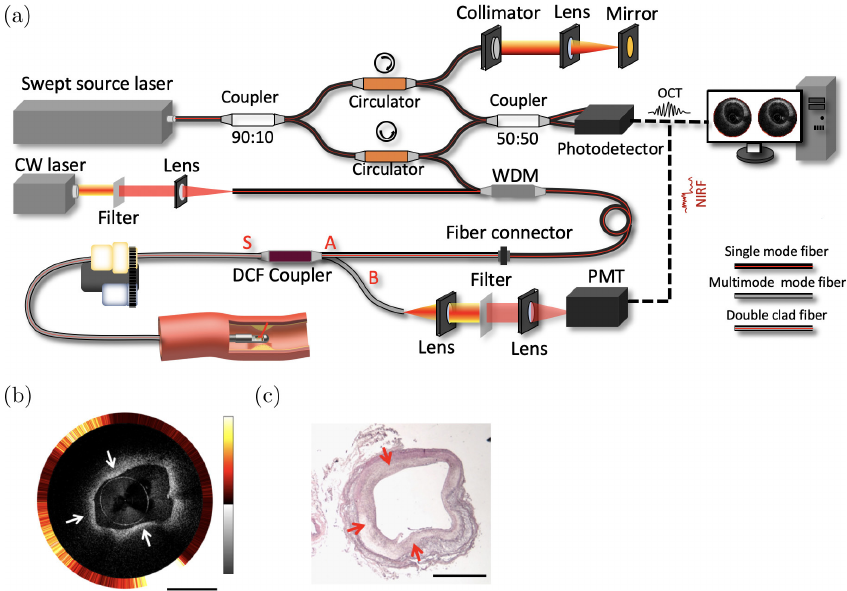
Fig. 2. Integrated IVOCT-NIRF. (a) A typical IVOCT-NIRF system schematic. WDM: wavelength-division multiplexing. DCF: double-clad ¯ber. PMT: photomultiplier tube. CW: continuous wavelength. (b) Representative IVOCT (inner) and NIRF (outer) image of a rabbit aorta in which high NIRF signals, denoted by the white arrows, are observed, indicative of macrophage aggre- gation. In the OCT image, thickening intimal is noted, which is supported by the histological reading. (c) The corresponding histology of (b). Scale bars: